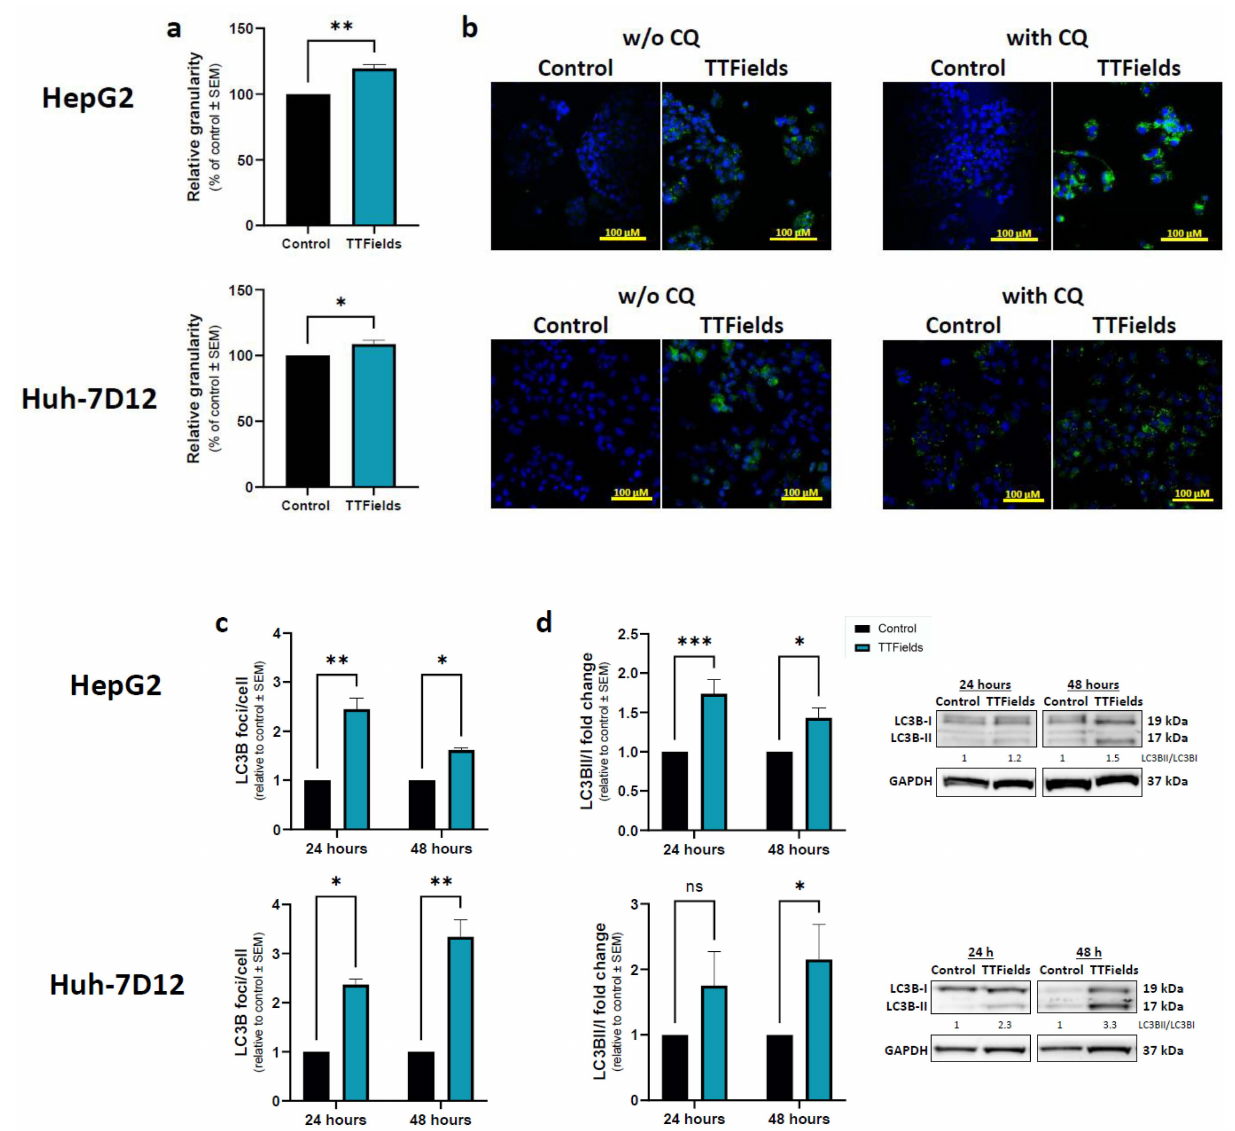
Figure 2. Effects of TTFields on autophagy levels in HCC cells. HepG2 and Huh-7D12 cells were treated with 150 kHz TTFields (1.0 and 1.7 V/cm RMS, respectively) for 72 h, and median side-scatter values were measured as representing changes in cellular granularity ( a ). Cells treated for 48 h were examined for LC3 foci formation by fluorescent microscopy, with or without addition of CQ during the last 3 h of the experiment ( b ), LC3 in green staining and DAPI in blue. Experiments performed with 24 or 48 h application of TTFields with addition of CQ during the 3 final hours of the experiments were quantified for LC3 foci formation by immunofluorescence ( c ), and for LC3-II to LC3-I ratio by immunoblotting ( d ). Values are mean ( N ≥ 3) ± SEM. * p < 0.05, ** p < 0.01, and *** p < 0.001, rela- tive to control; two-way ANOVA. ANOVA = analysis of variance; CQ = chloroquine diphosphate; DAPI = 4 (cid:48) ,6-diamidino-2-phenylindole; HCC = hepatocellular carcinoma; ns = non-significant; RMS = root mean square; SEM = standard error of the mean; TTFields = Tumor Treating